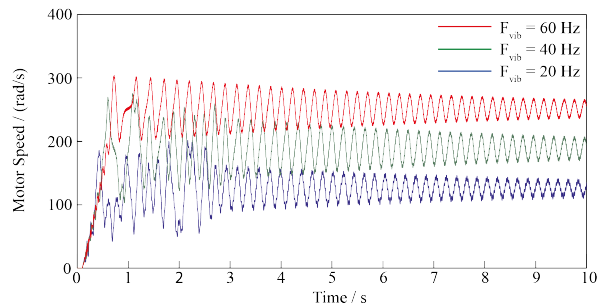
Figure 12. Simulated motor speed with respect to frequency and time.